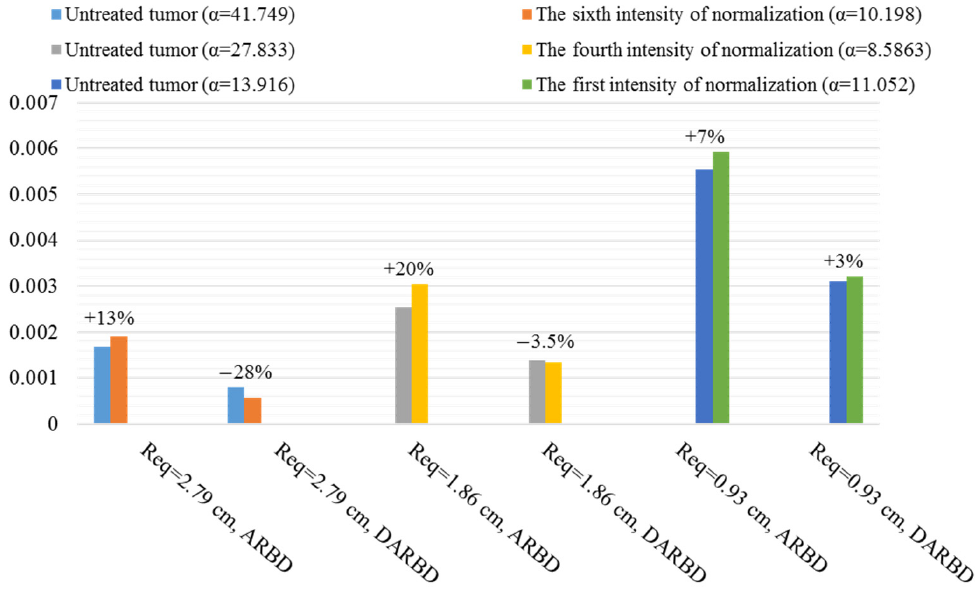
Figure 13. Summary of the positive influence of normalization on ARBD and DARBD of F ( ab (cid:48) ) different sizes. The percentage of change after applying the AAIN is seen above the